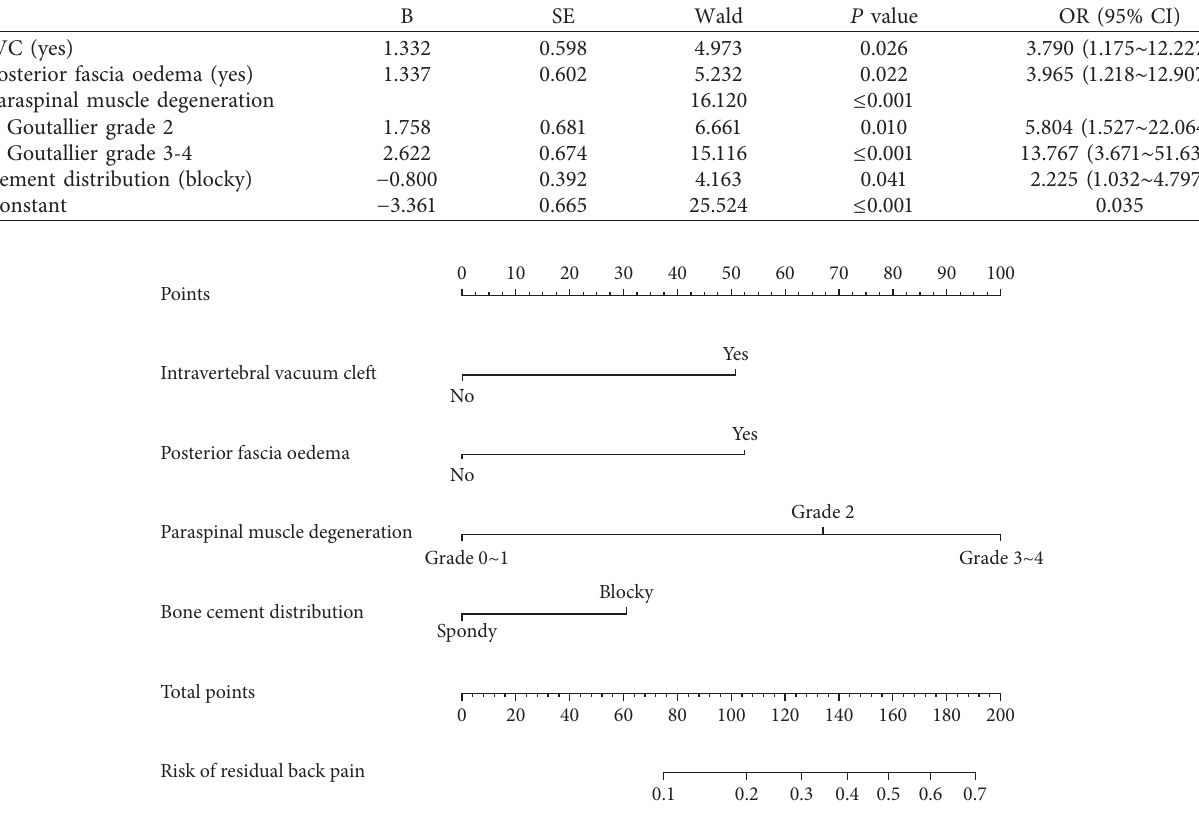
Table 5: Multivariate logistic regression analysis for the influence factors of postoperative residual back pain after PVP.